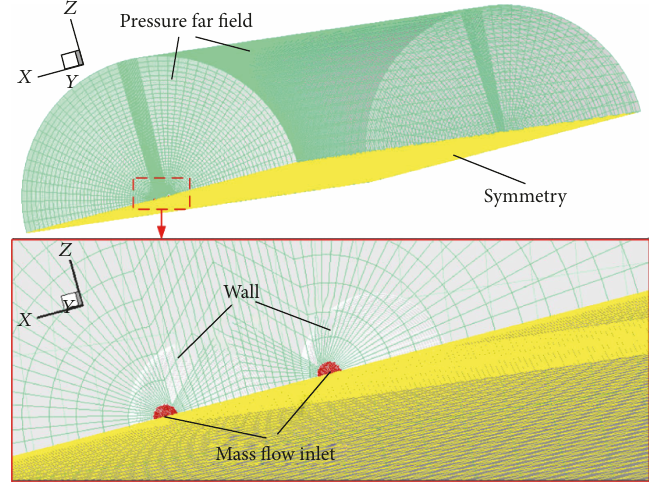
Figure 3: Mesh and boundaries of plume fl ow fi eld of double-nozzle